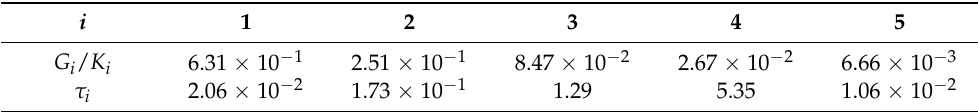
Table 2. Parameters of Mohr-Coulomb model. Table 1. Prony series parameter of linear viscoelastic